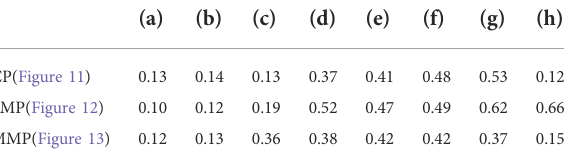
TABLE 1 gCNR of PAE images acquired along three typical screw implantation paths.